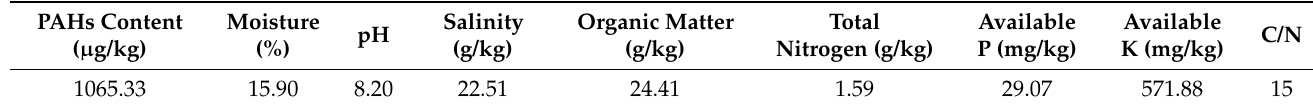
Table 1. Total PAH contents and physicochemical properties of the